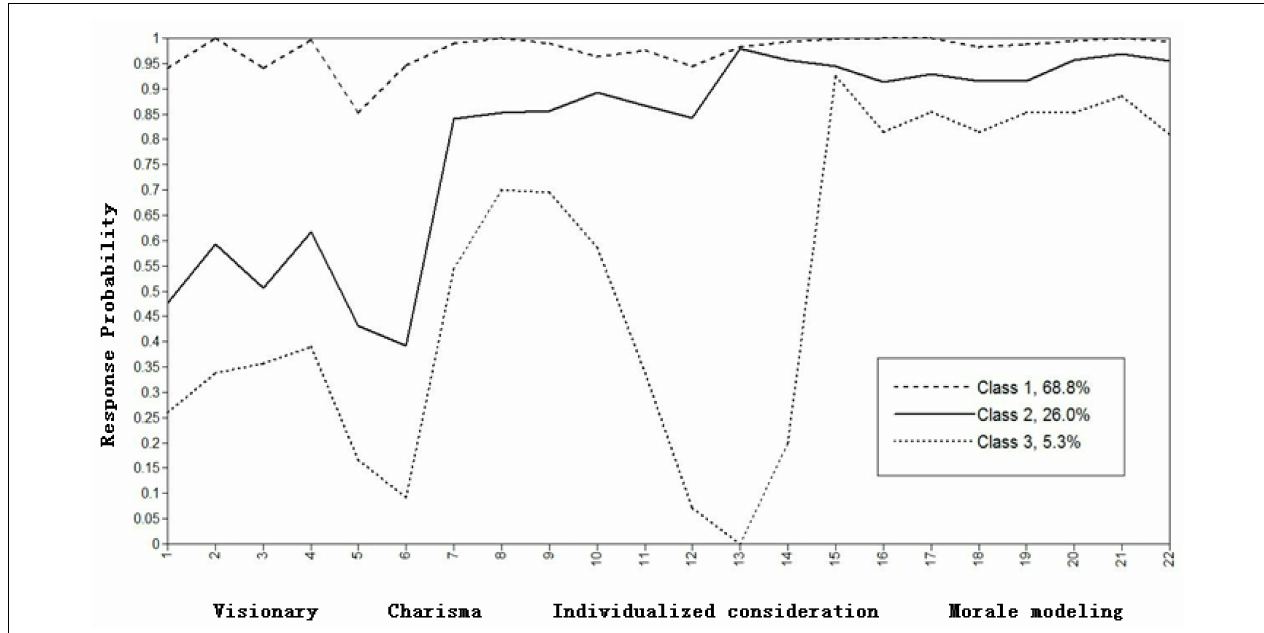
FIGURE 1 | The response probability diagram of each latent class on all entries. In data analysis, the original scale items are rearranged according to the items included in each dimension, i.e., 1 ∼ 4 is the visionary, 5 ∼ 9 is the charisma. 10 ∼ 14 is the individualized consideration. 15 ∼ 22 is the morale modeling. TABLE 4 | Comparison of organizational climate scores of kindergartens with different leadership types (M ± SD). The type of transformational leadership of the director of the